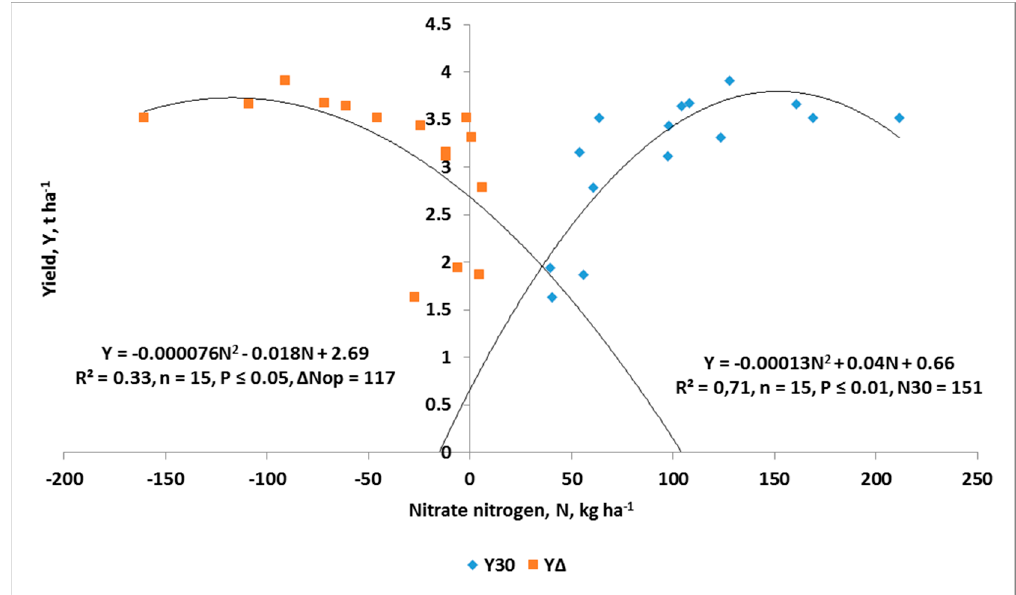
Figure 7. Yield prediction based on the N-NO 3 management during stem elongation phase of WOSR growth.